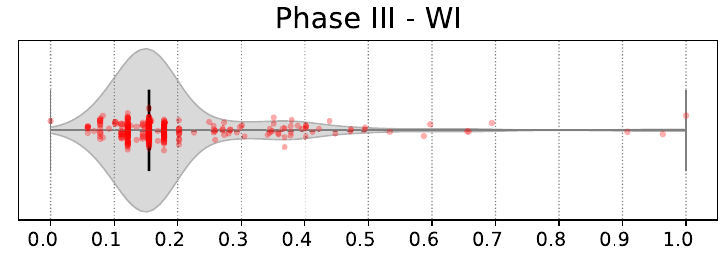
Figure 8: WI distribution of Dunaújváros Phase III ( c. 1650 – 1450 BCE ) . Bold black bar indicates the